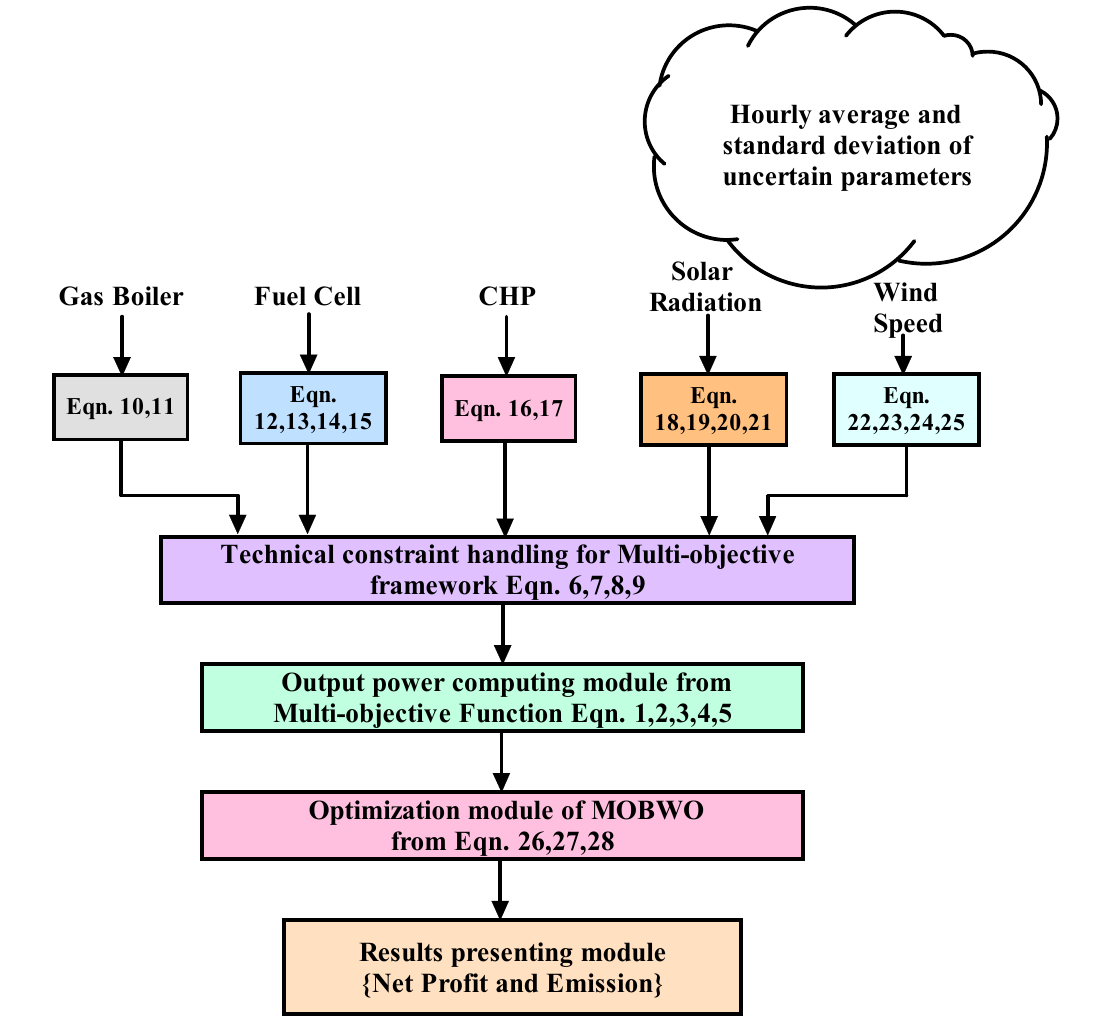
Figure 8. Process flow for the adopted methodology.